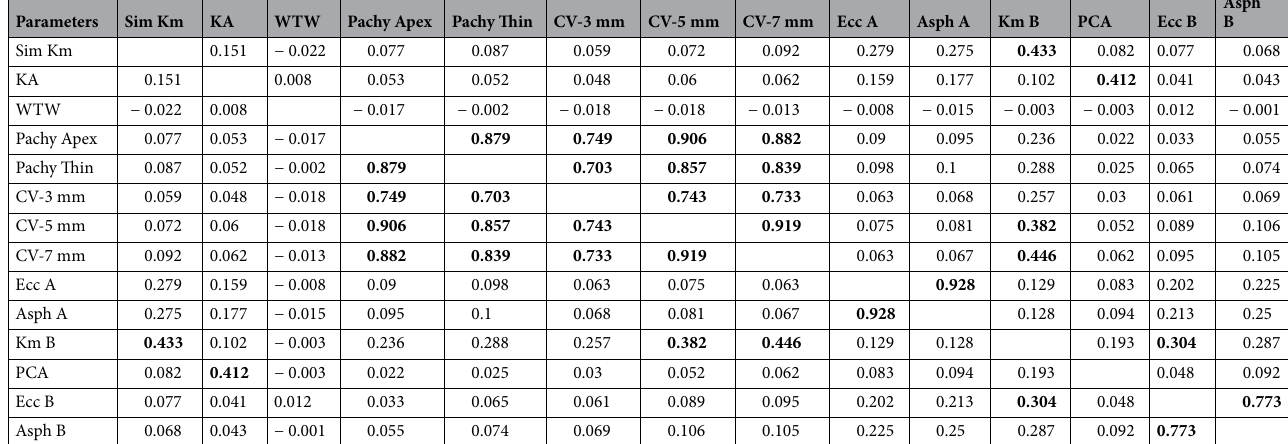
Table 4. Spearman’s correlation coefficient ( r ) between the right-to-left ratios of different corneal biometrics. Correlations with an r > 0.3 and a p < 0.05 are highlighted in bold. SE spherical equivalent; KA keratometric astigmatism; WTW white-to-white; Thin, thinnest point; CV corneal volume; ECC A anterior corneal eccentricity; Asph A anterior corneal asphericity; Km B mean posterior corneal curvature; PCA posterior corneal astigmatism; ECC B posterior corneal eccentricity; Asph B posterior corneal